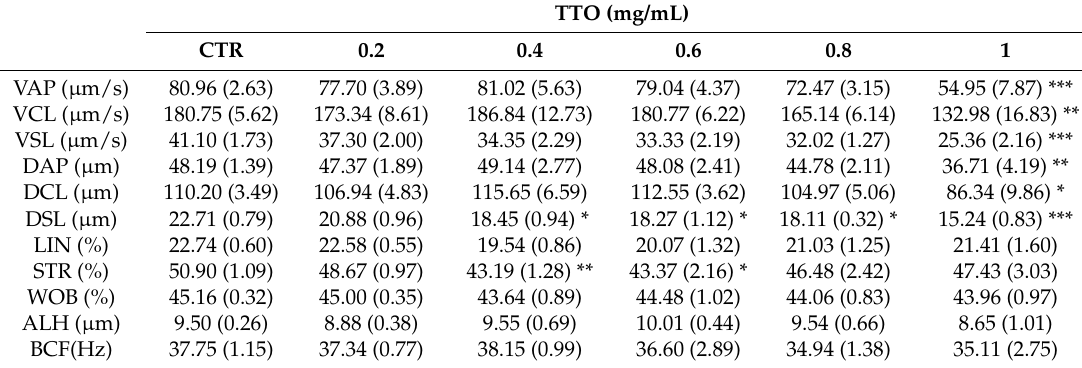
Table 3 (TER). The analysis of variance for the TTO group highlighted statistical differences for VAP, VCL, VSL, DAP, DCL, DSL, and STR; on the other hand, only VSL, DSL, LIN, and STR resulted statistically altered for the TER group. Table 2. Effects of tea tree oil (TTO) on sperm kinematic parameters for samples with total motility ≥ 20%. Data are reported as Mean (standard error of the mean), n = 9. Differences were calculated